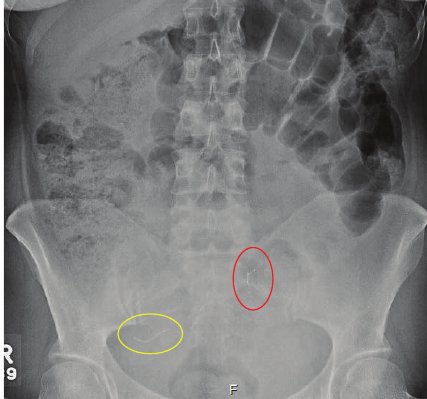
Figure 3: Patient Number 1, postpartum abdominal X-ray 8/30/2014: Essure (circled in red) in the abdomen.